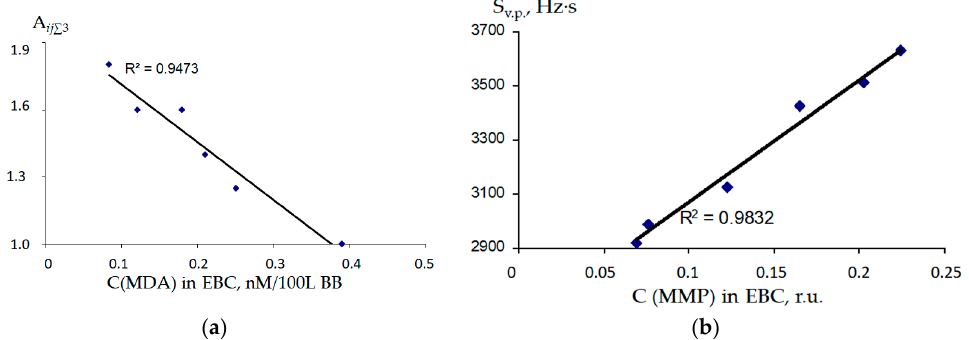
Figure 8. Dependencies of the sorption parameters of an array of sensors with polycomposite coatings on the biochemical parameters of the EBC: ( a ) the A ij ∑ 3 parameter on the MDA content; ( b ) the area of the “visual print” (S v.p. ) on the content of the MMP.